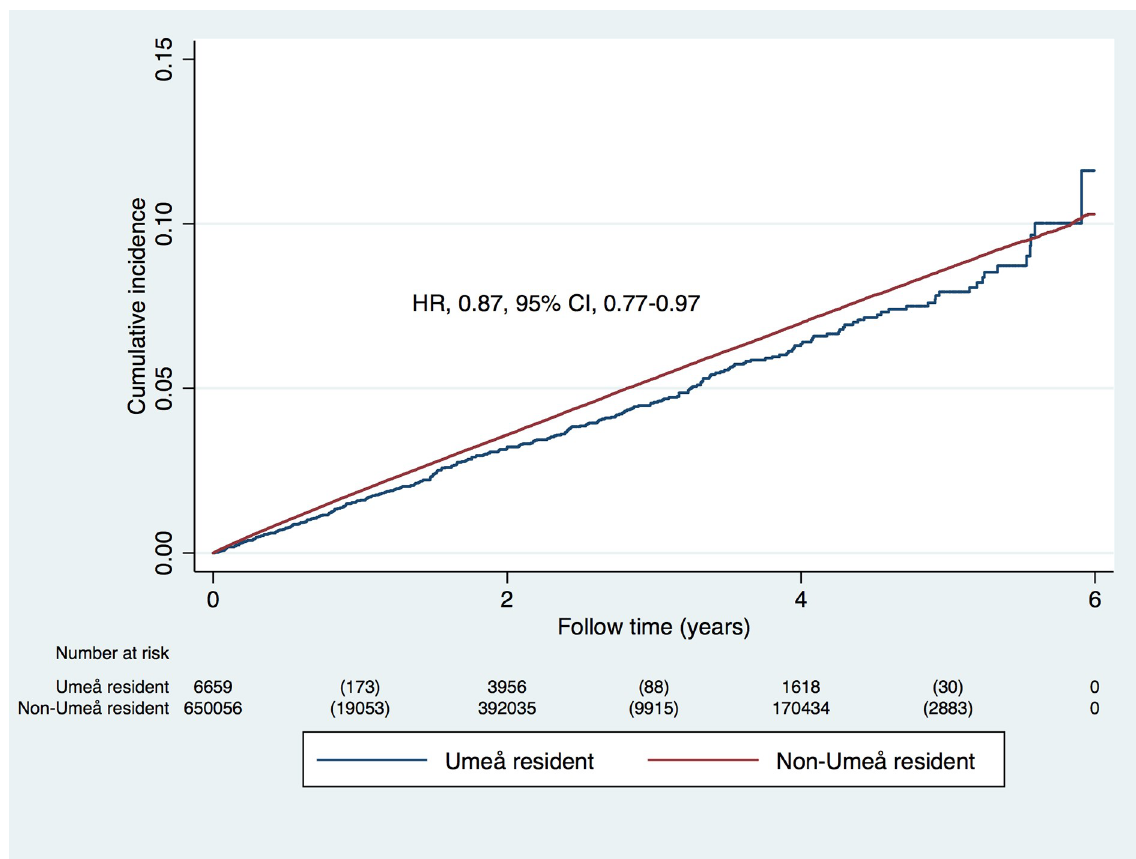
Fig 3. Risk of stroke, myocardial infarction, or angina pectoris in 70-year-old Ume å residents and in 70-year-olds from the rest of Sweden with baseline date in 2012–2017. The hazard ratio (HR) is presented for time to first outcome, and below the figure the number at risk at each time point is presented, together with the number of outcome events within